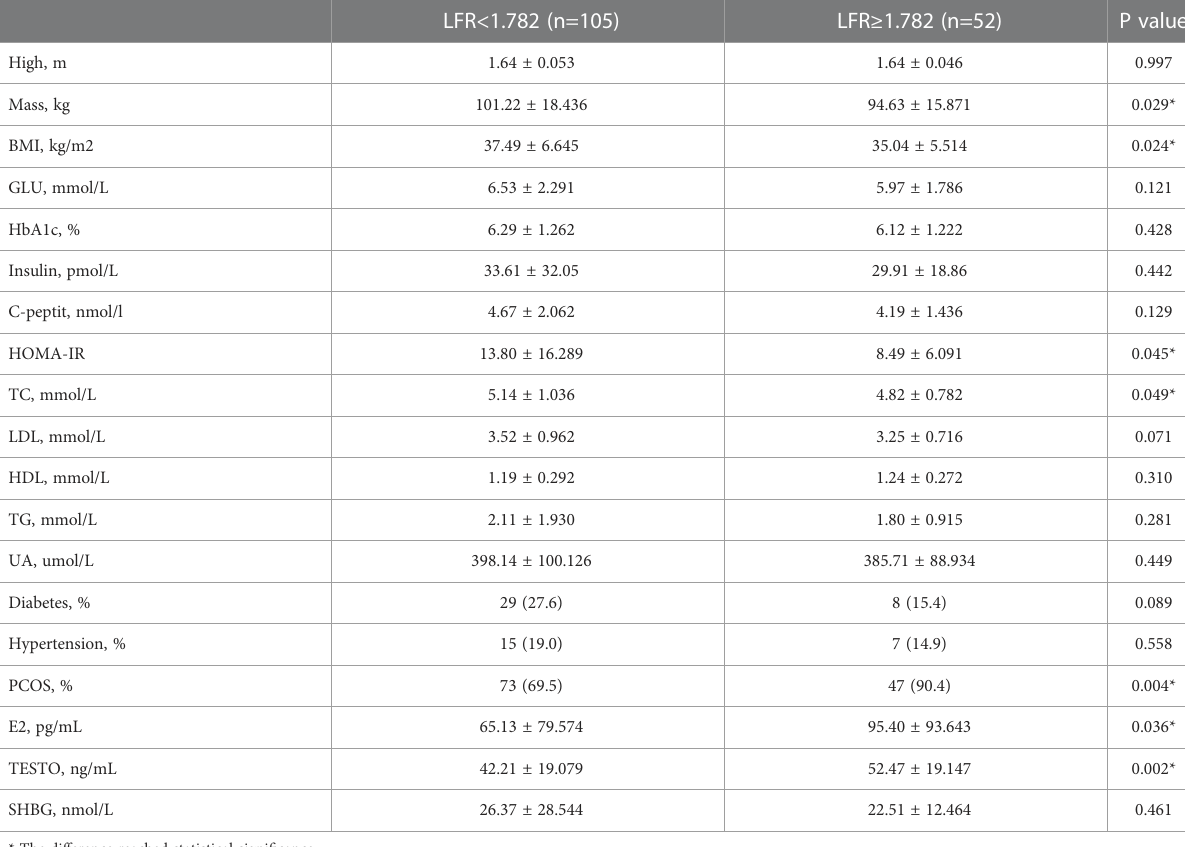
TABLE 6 Association with preoperative indices according to the cut-off value classi fi cation of